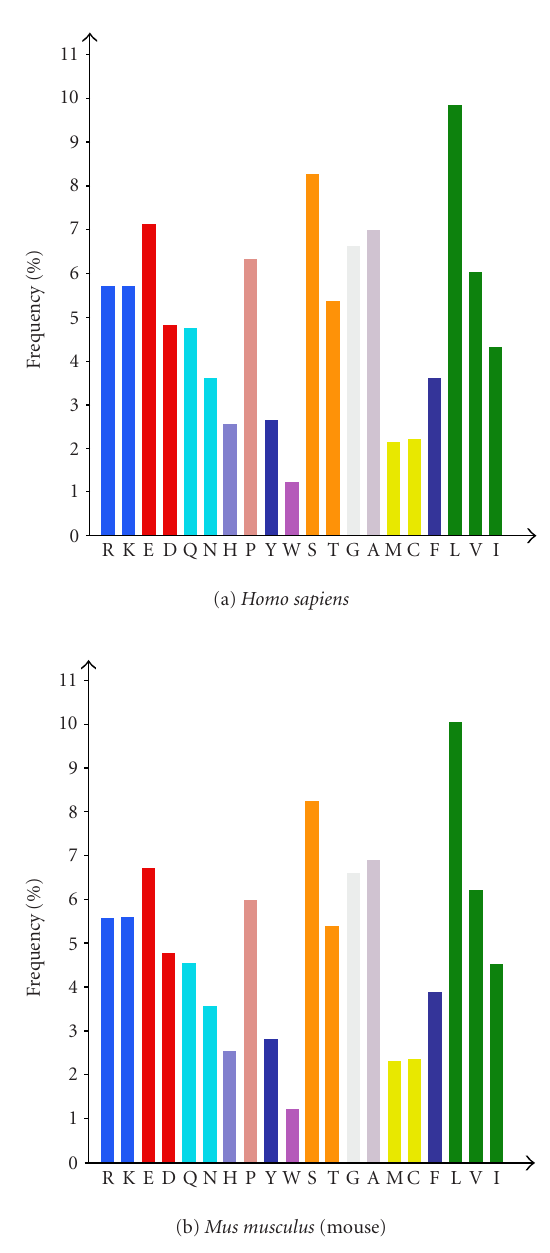
Figure 2. Amino acid composition of Homo sapiens and Mus musculus . (The total number of each amino acid in each pro- teome is given additionally as well as the frequency in